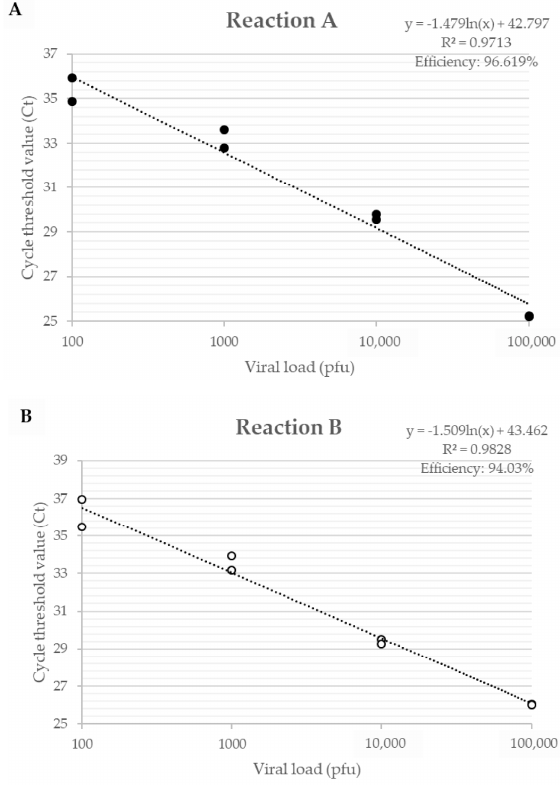
Figure 2. Efficiency curve of A56R gene qPCR in coinfection of PV1-GII and PV2-GI. Uninfected Balb/c mice lungs were spiked with 10 6 , 10 5 , 10 4 , 10 3 , 10 2 and 10 1 p.f.u. of PV1-GII and PV2-GI. ( A ) in Reaction A shown in black circles , primers A56R -gen F and A56R -gen R were used; and ( B ) in Reaction B shown in white circles , primers A56R -BVV-nDEL F and A56R -generic R were used.